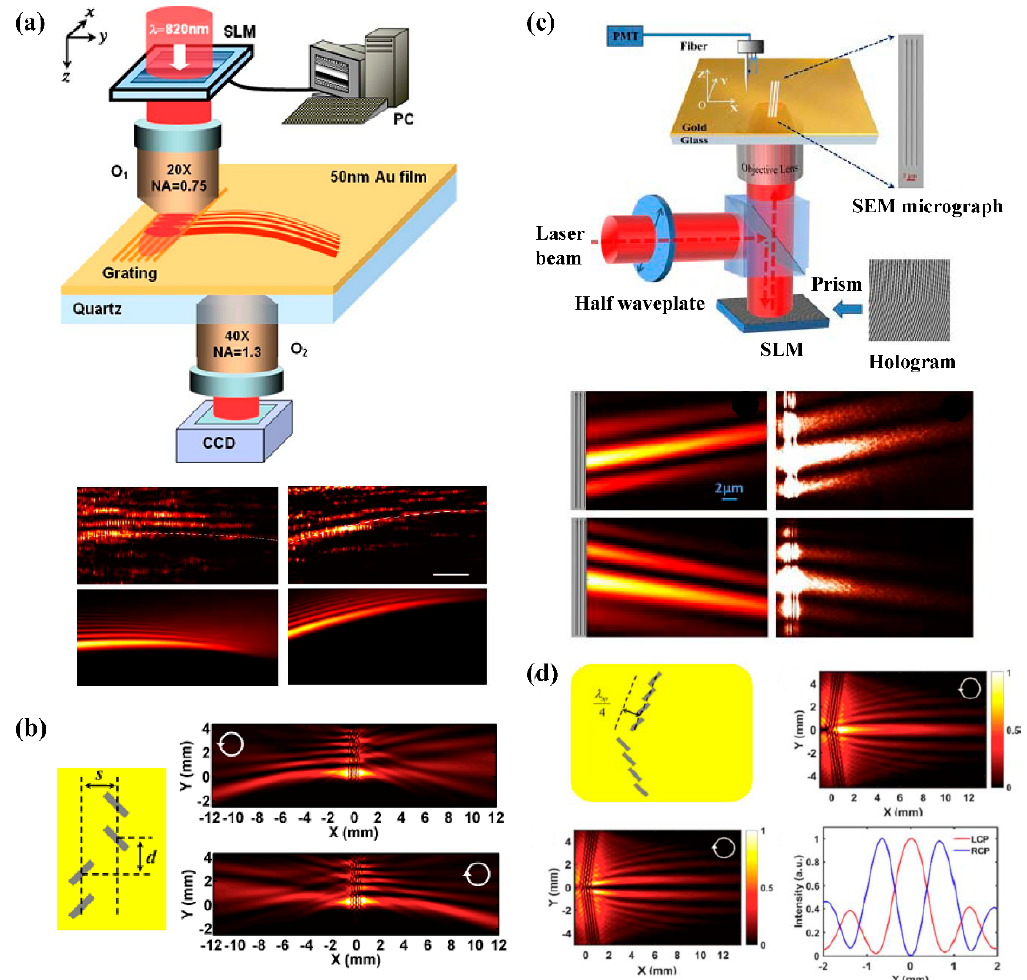
Figure 6. ( a ) Dynamic modulation of the trajectory of SPP Airy beam with SLM [42]; ( b ) Controlling the position of the SPP Airy beam by varying the incident polarization [74]; ( c ) Dynamic SPP Bessel beam through phase control [41]; ( d ) Polarization-based manipulation of SPP Bessel beams [75]. Reproduced with permissions from: [42], OSA, 2011, [74], OSA, 2017, [41], OSA, 2014, [75], OSA, 2018.